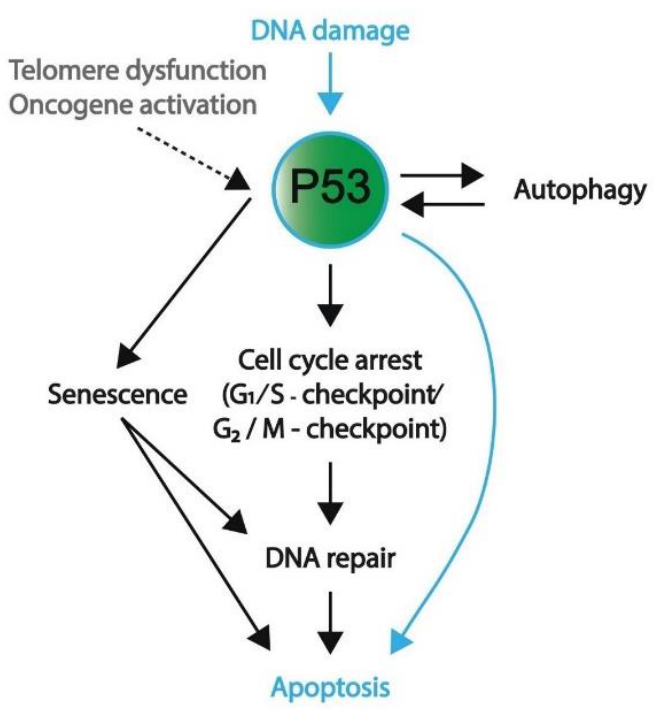
Figure 4. A schematic overview representing the favored mechanism of P53 activation in embryonic cells and somatic cells. DNA damage, both in embryonic (blue) and somatic (black) cells, will induce P53 activation. To protect genomic integrity, embryonic cells favor apoptosis over DNA repair. Conversely, somatic cells preferentially engage in cell cycle arrest and DNA repair; however, if DNA damage persists, these cells will enter apoptosis or become senescent. Furthermore, telomere dysfunction and oncogene activation are other means to activate P53 signaling (mostly in somatic cells). In addition to apoptosis, P53 activation and its downstream pathways can result in autophagy, senescence, and cell cycle arrest.